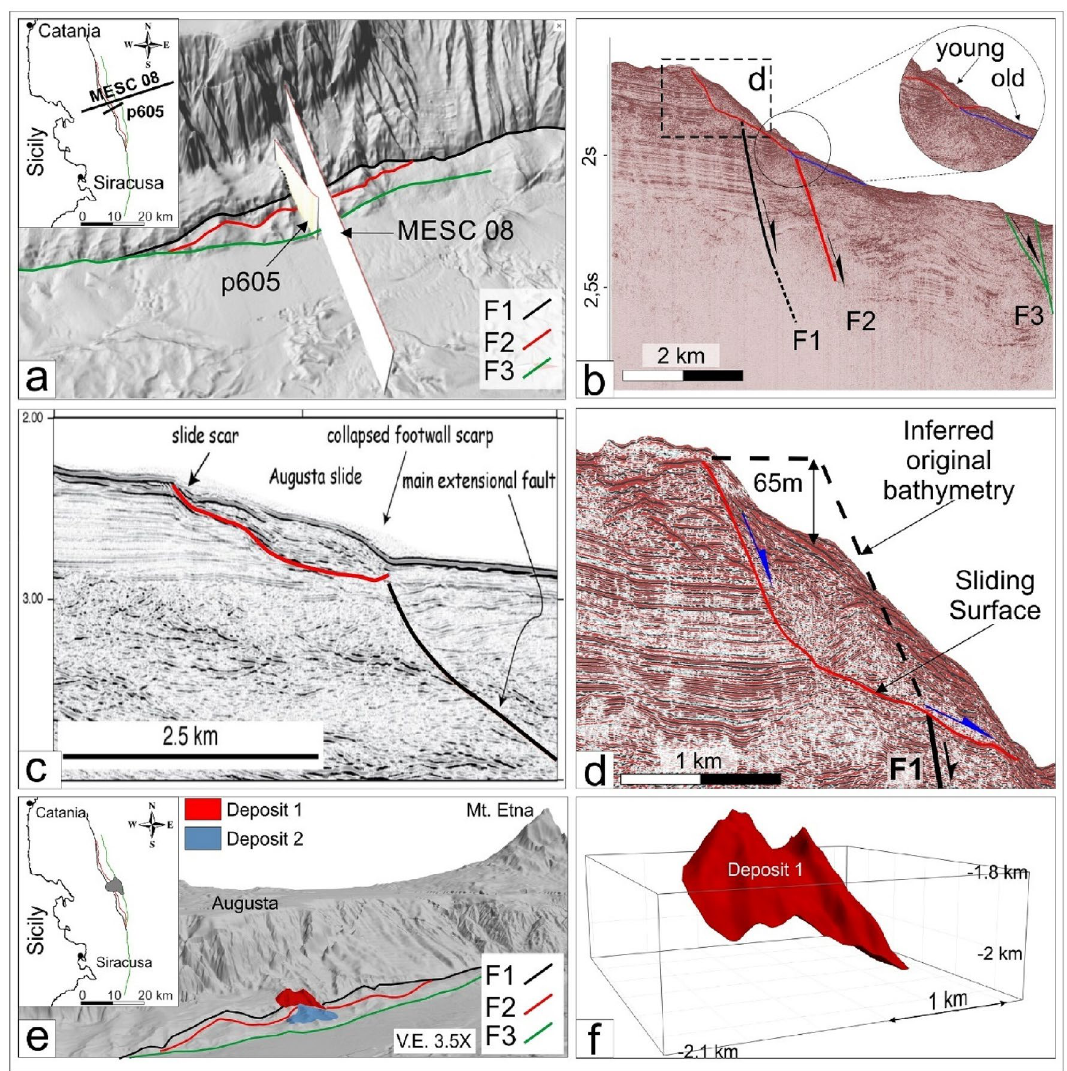
Figure 4. 3D modelling of the submarine landslide deposits. ( a ) Location of main faults and seismic profiles (see Gambino et al. 26 ) passing across the submarine landslide deposits. ( b ) P605 seismic profile showing the two identified landslide deposits offshore Augusta (red and blue lines indicate deposit 1 and 2 sliding surfaces, respectively). ( c , d ) Seismic expression of the most recent landslide deposit 1 along the MESC 08 (Argnani et al. 28 ) and P607 profiles, respectively. ( e ) Perspective view (from SE) showing the seafloor expression of the mapped landslide deposits deriving from 3D modelling. ( f ) modelled 3D volume of deposit 1 within the MOVE software—version 2020-12.5, https:// www. petex. com/ produ cts/ move- The described landslides fall in the area where the maximum macroseismic Intensity (XI) for the historical earthquakes was reconstructed by Barbano et al. 48 . According to the relationships between macroseismic Inten- sity and Peak Groud Acceleration (PGA) (see Wald et al. 75 among many others), an Intensity XI correspond to a PGA > 1240 Gal or to a PGV (Peak Groud Velocity) > 116 cm/s, consistent with triggering of submarine landslides. In particular, according to the CPTI15-vers.4 49 , the January 11, 1693 seismic event was a quite pow- erful earthquake with estimated Magnitude of 7.4 (see Table 1). Using this magnitude value and empirical scale-relationships 76 , a distributed coseismic slip of at least 4.8 m over the whole F3 fault plane is required to trigger such an intense seismic event. The magnitude of the expected slip was then exploited to perform elastic dislocation models (see Okada 77 ), aimed at estimating the expected coseismic displacement of the seafloor pre- dicted on the basis of the mechanical properties assumed for the medium involved (Table 2). Considering the stress field acting in the area (see Gambino et al. 26 ), a dip-slip motion of 4.8 m was simulated along the entire F3 fault plane. A 2 m hangingwall subsidence, and a 0.3 m footwall uplift have been predicted, resulting in a 2.3 m coseismic fault-scarp at the seafloor (Fig. 5). Three different tsunami scenarios have been modelled using the source parameters reported in Table 2. Multiple simulations were performed to simulate the most probable scenario according to different faulting/ landslide delays. According to the three scenarios, tsunami modelling provides different dynamics of triggering,